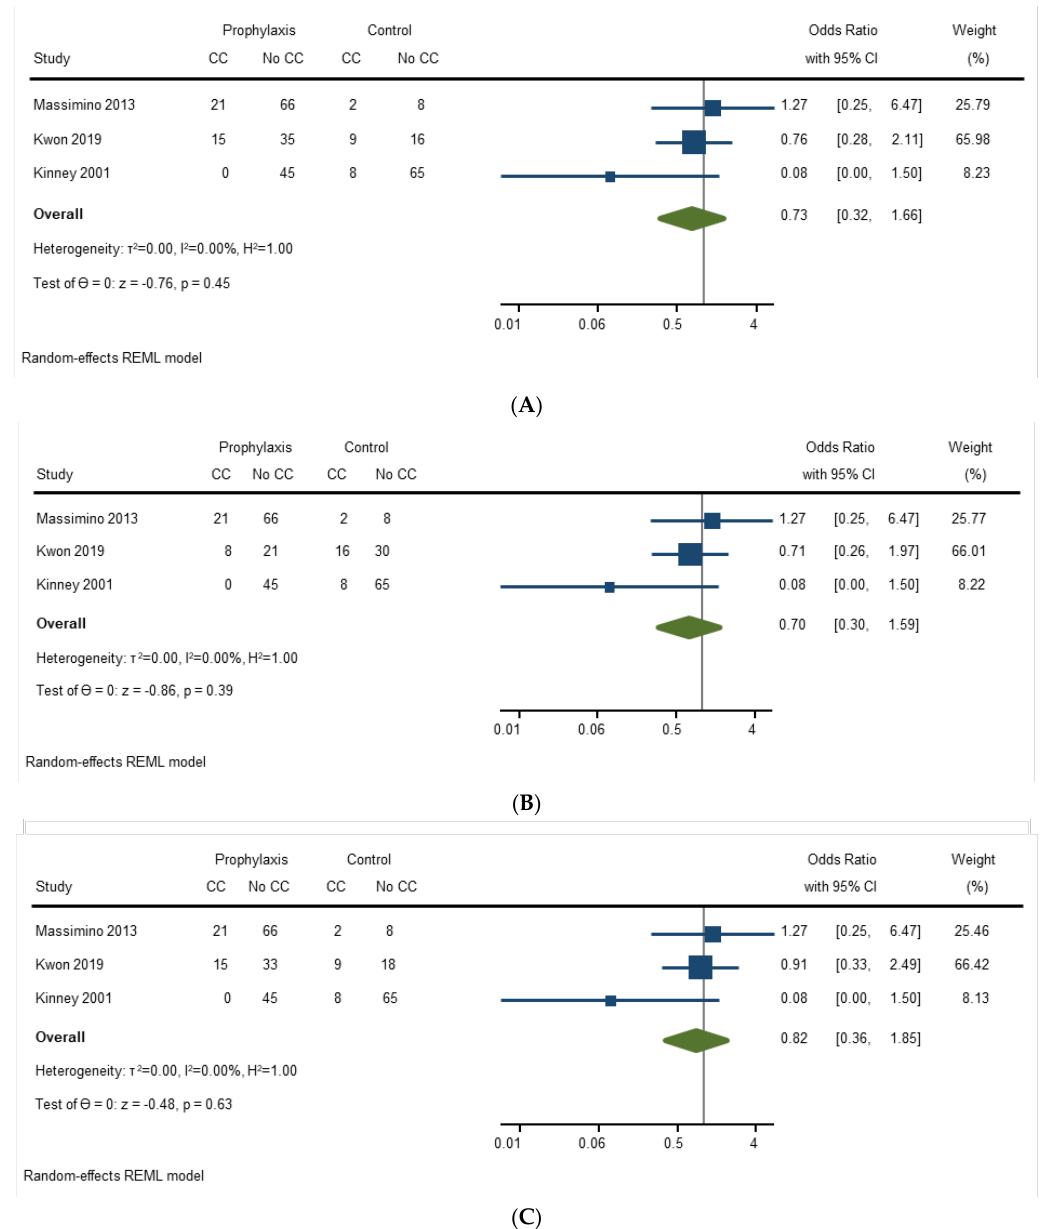
Figure 3. ( A ) Forest plot evaluating efficacy of octreotide in prevention of carcinoid crisis, all strategies included (pre- and intraoperative bolus/infusion); ( B ) Forest plot evaluating efficacy of octreotide in prevention of carcinoid crisis, preoperative octreotide (dominant strategy); ( C ) Forest plot evaluating efficacy of octreotide in prevention of carcinoid crisis, intraoperative octreotide (dominant strategy)